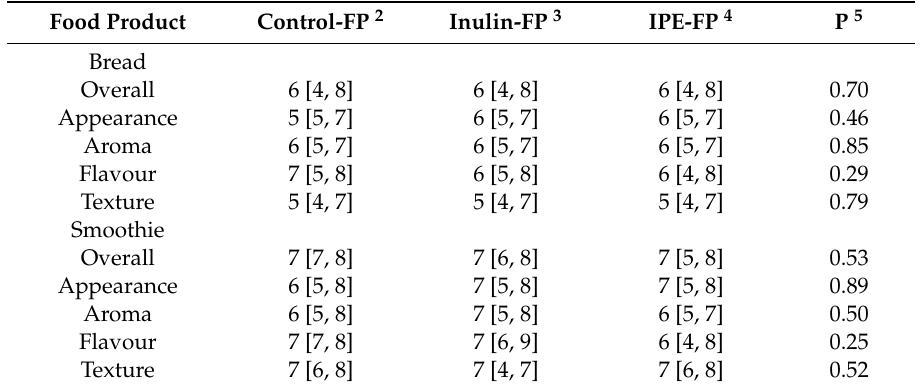
Table 3. Food product satisfaction ratings for inulin-FP and IPE-FP compared to control-FP 1